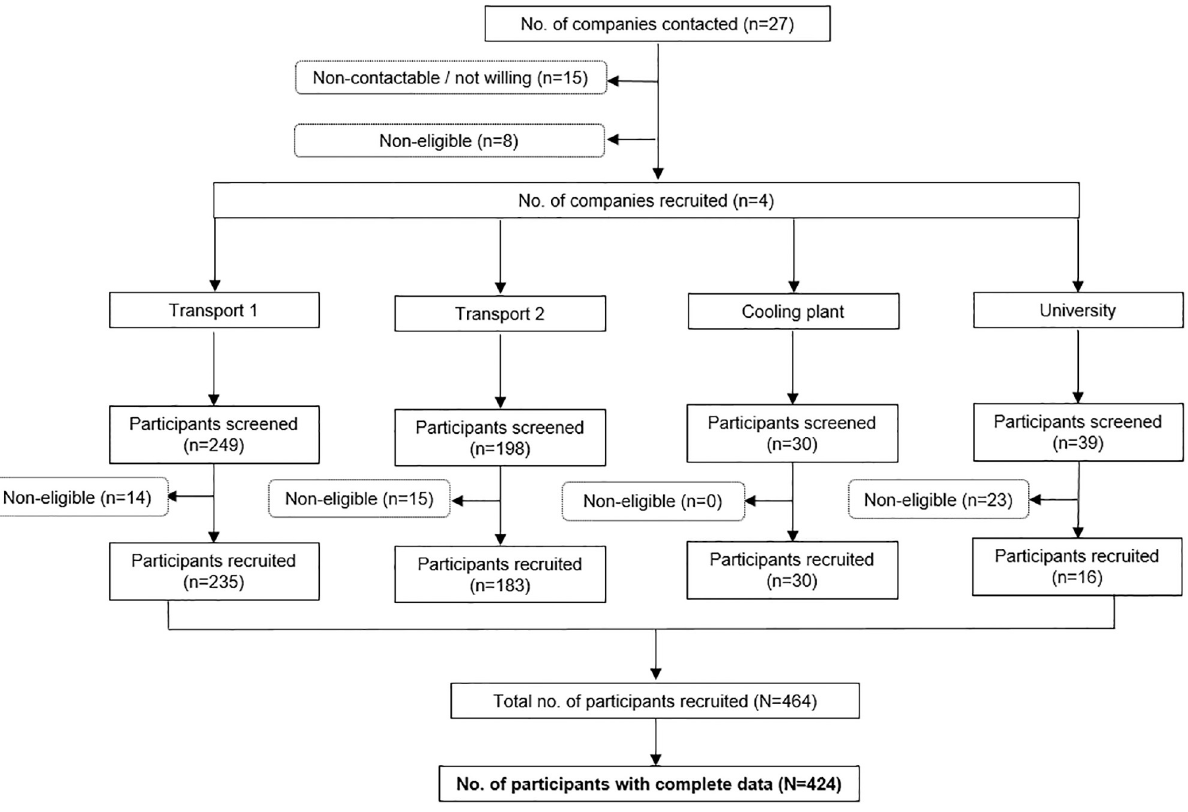
Fig 1. Flow diagram of recruitment process of study